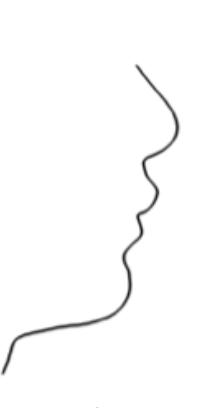
Figure 4. Silhouette of class II premolars extractions post